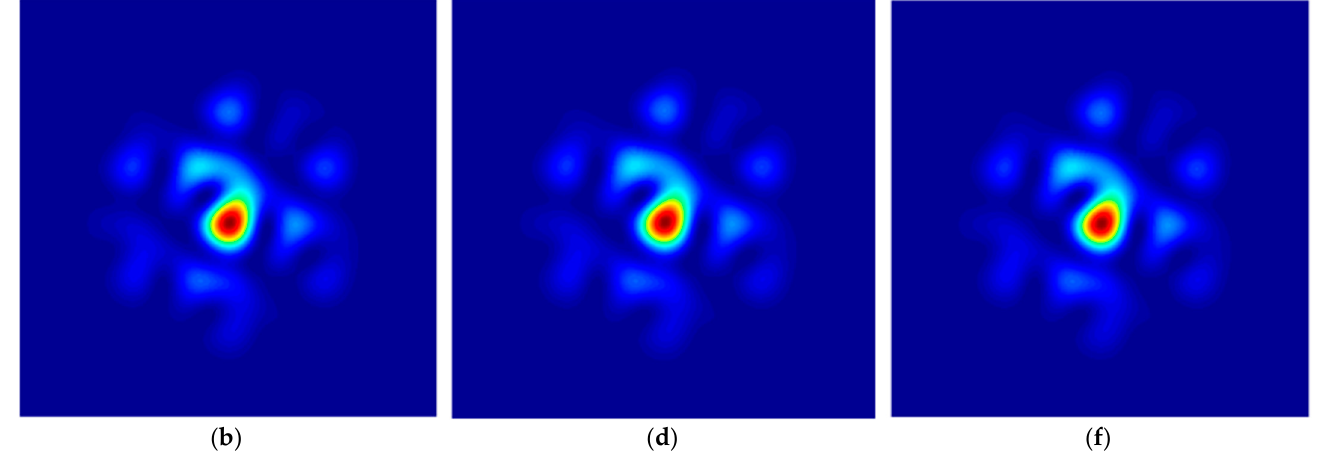
Figure 2. Three different piston phases which can generate the same far-field. ( a , b ) Phase1 and its far-field. ( c , d ) Phase2 (adding a common phase to phase1) and its far-field. ( e , f ) Phase3 (rotating phase1 180 degrees and conjugating it) and its far-field.